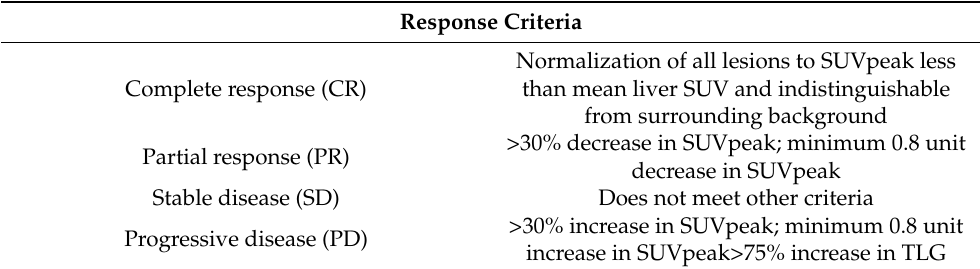
Table 3. mPERCIST criteria from Wahl [29], modified by Fendler et al. [31]. Response Criteria Complete response